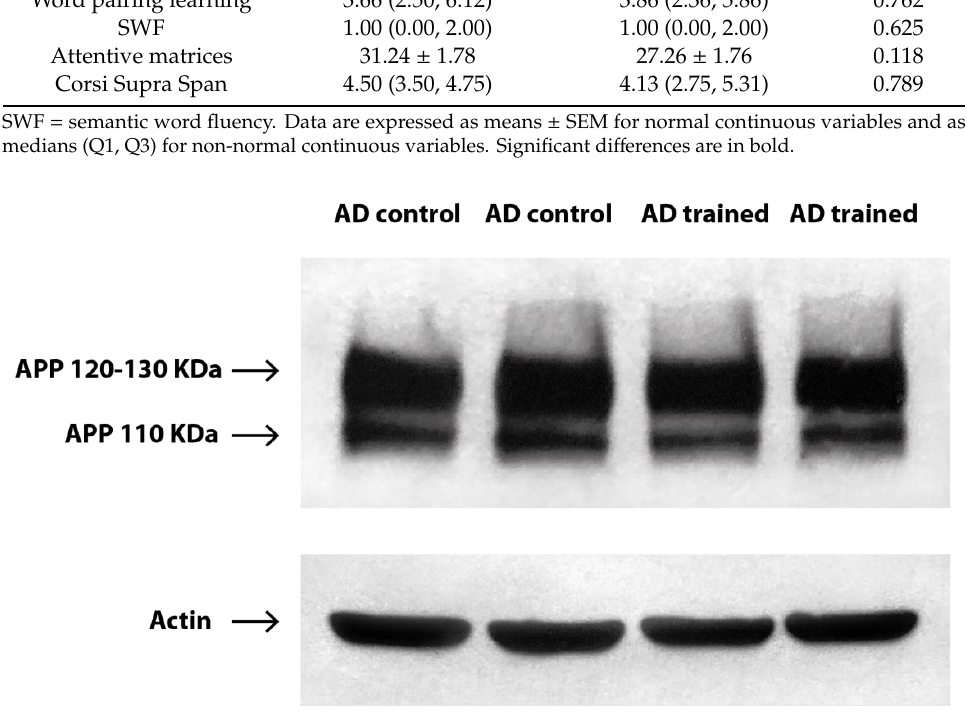
Figure 1. Western blots of APP and actin in platelet homogenates in the AD control and trained subjects at baseline. Samples were run in duplicate. AD trained subject is a 75-year-old woman with an MMSE of 22.3 and an APPr of 3.11. AD control subject is a 78-year-old man with an MMSE of 21.7 and an APPr of 2.94. The double band of APP at 120–130 kDa and 110 kDa is clearly visible. Actin was used as a loading